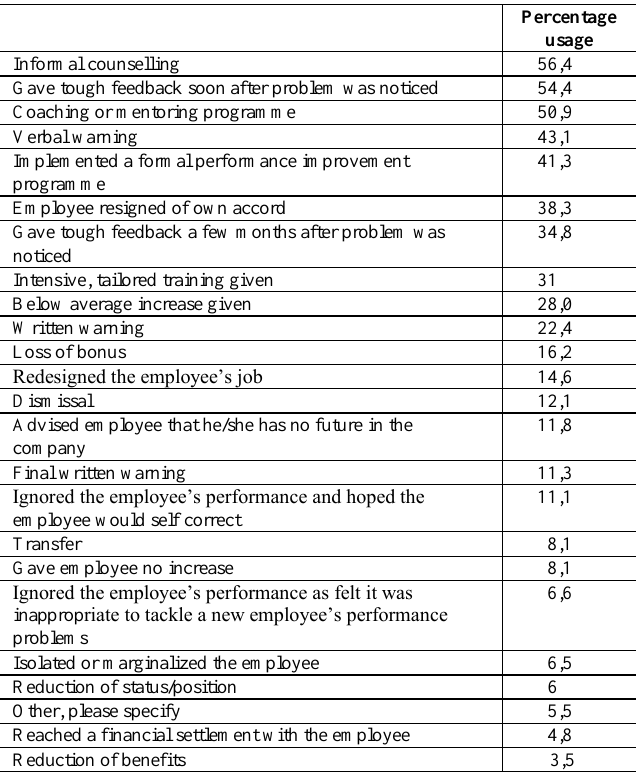
Table 5: Responses to poor Percentages